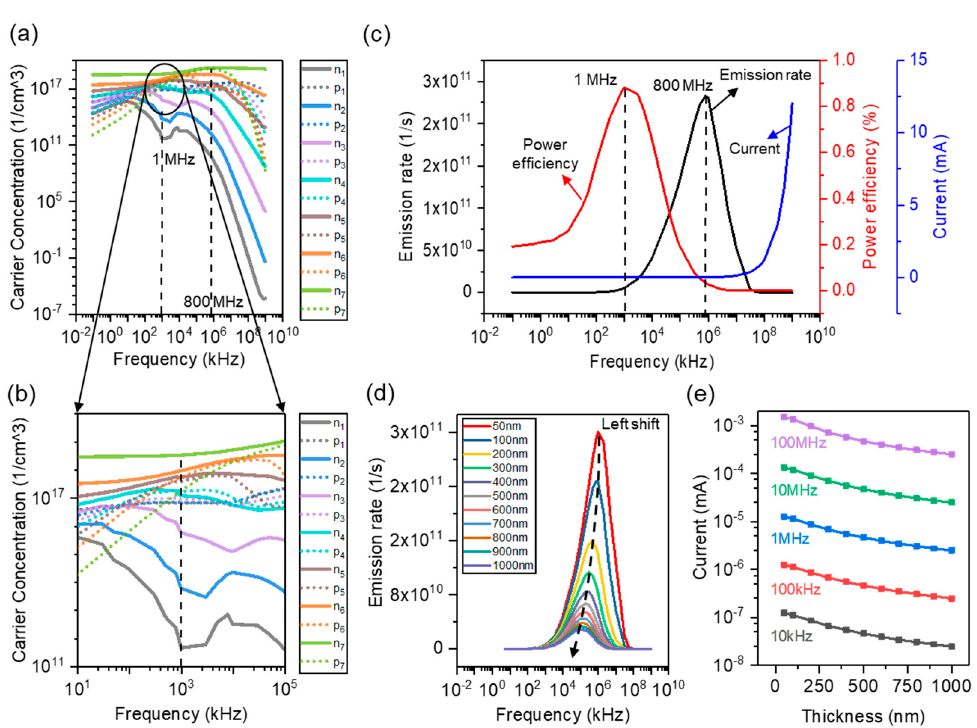
Figure 8. Frequency response characteristics of the device. ( a ) Carrier concentration in the MQWs at different frequencies. ( b ) Carrier concentration in the MQWs at 1 MHz. ( c ) Emission rate and the power efficiency at different frequencies. ( d ) Emission rate with different insulator thicknesses at different frequencies. ( e ) Peak current with different insulator thicknesses at different frequencies.